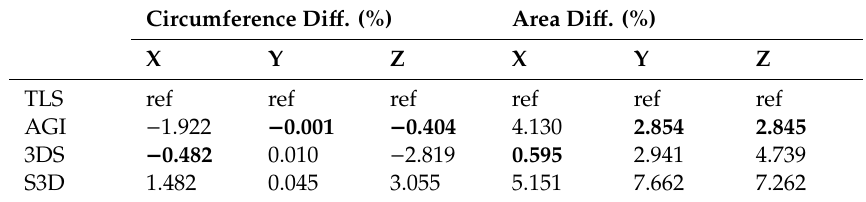
Table 6. Boulder No. 1: circumference and the section area—model differences (in percents).